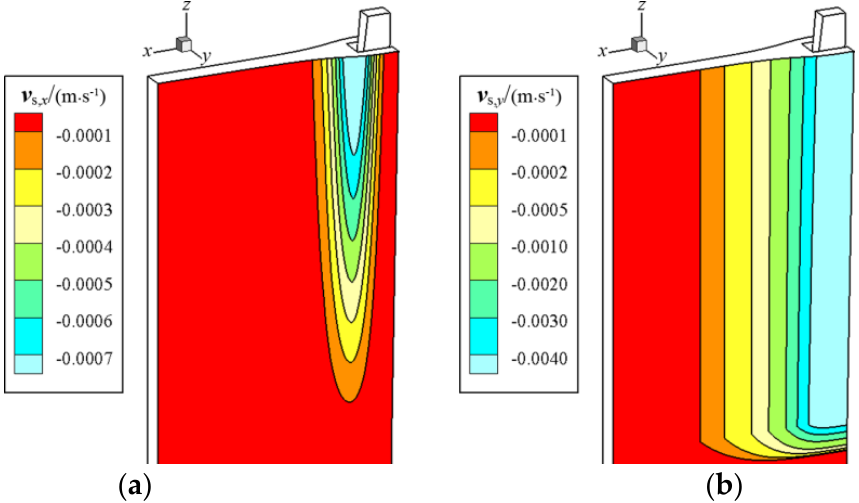
Figure 6. Schematic distribution of shell surface velocity on the funnel region of the CSP mold: ( a ) X -velocity and ( b ) Y -velocity.